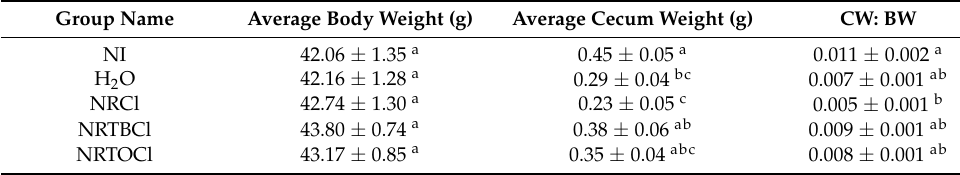
Table 2. Gross physiological parameters measured on the day of hatch (Day 21) 1 .